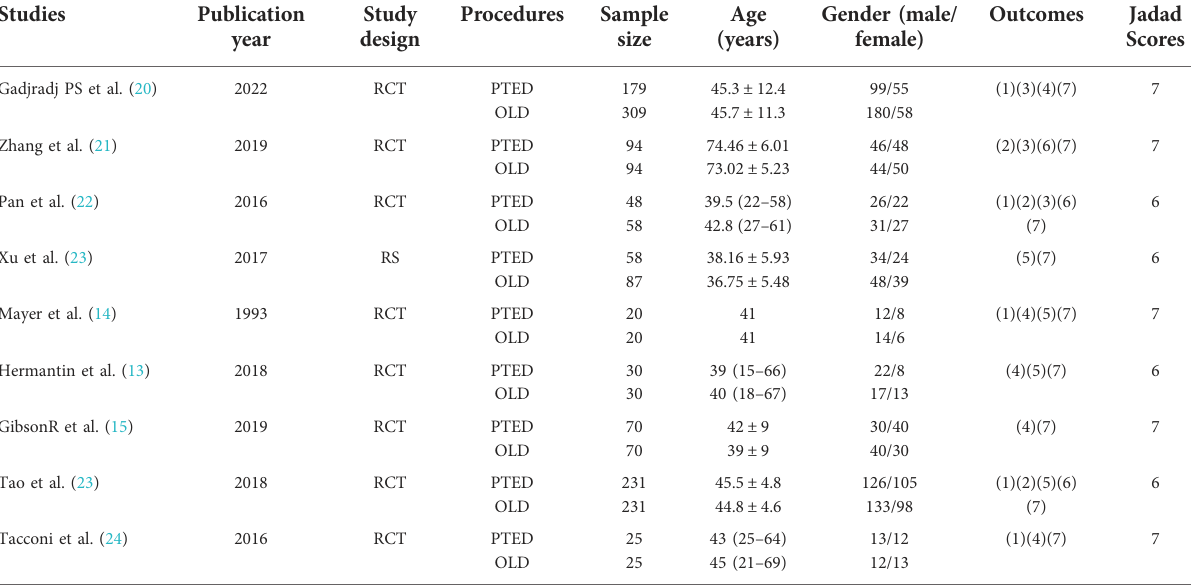
TABLE 1 Characteristics of including